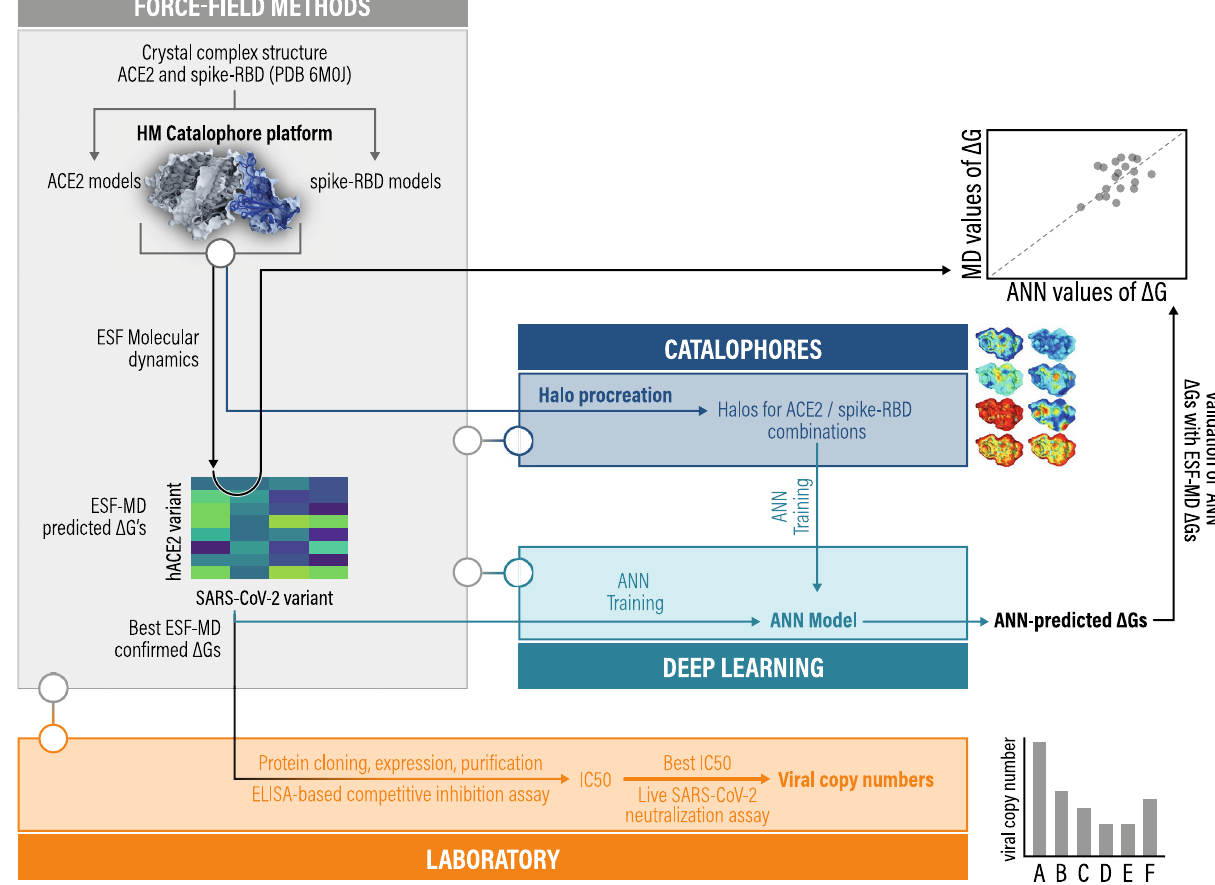
Figure 1. Multi-level strategy to identify high-affinity human ACE2 (hACE2) variants for neutralization of diverse SARS-CoV-2 variants. In brief, homology models (HM) of varying SARS-CoV-2 spike receptor binding domain (RBD) structures in complex with hACE2 variant structures served as input for molecular dynamics (MD) simulations analyzed via an empirical scoring function (ESF) closely related to the linear interaction energy (LIE) model. Gibbs free energy predictions (ΔG) were combined with Catalophore Halos to train an artificial neural network (ANN). This enables the model to predict ΔG values for hACE2- and SARS-CoV-2 variants based on their Halos. ANN ΔG predictions were validated with ESF ΔG values. The SARS-CoV-2 neutralizing potential of promising hACE2 variants was evaluated in ELISA-based competitive inhibition assays followed by live SARS-CoV-2-based neutralization